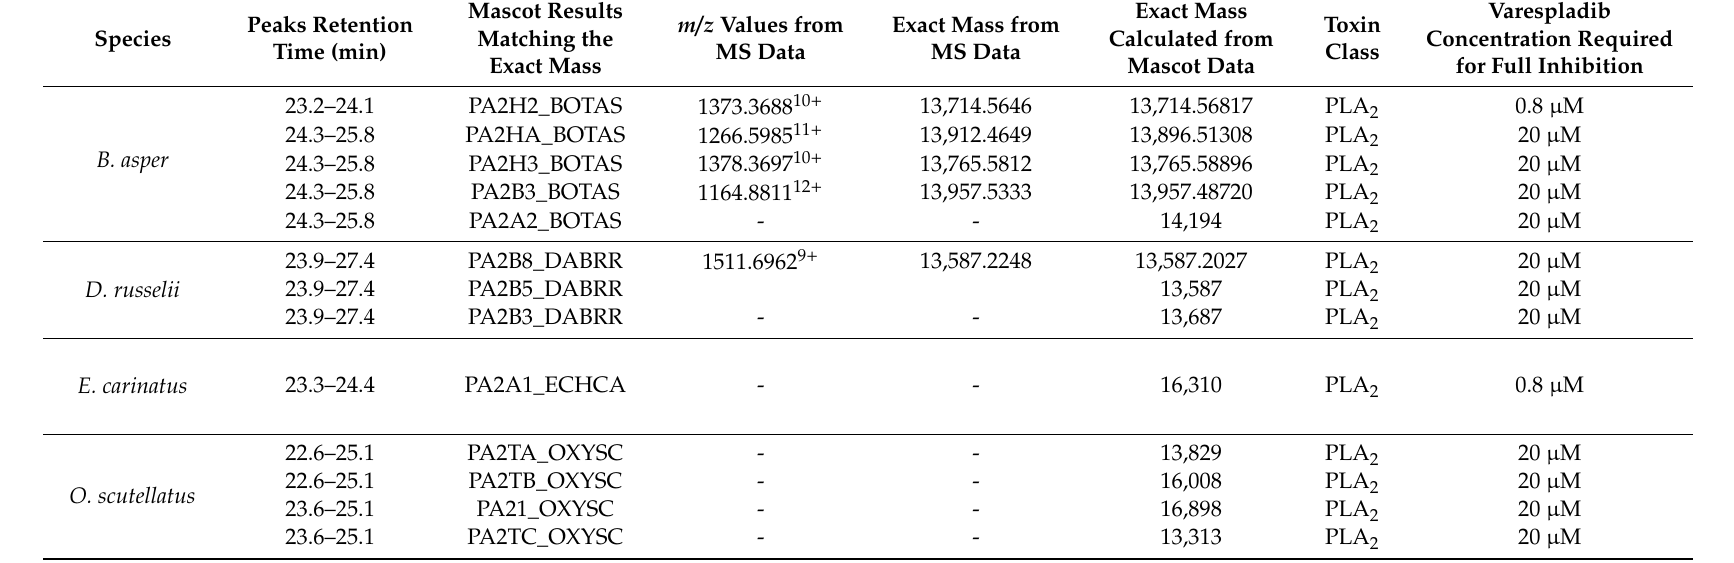
Table 1. Correlated accurate molecular masses and proteomics data for PLA 2 activities (peak retention times are adapted from Figure 3).